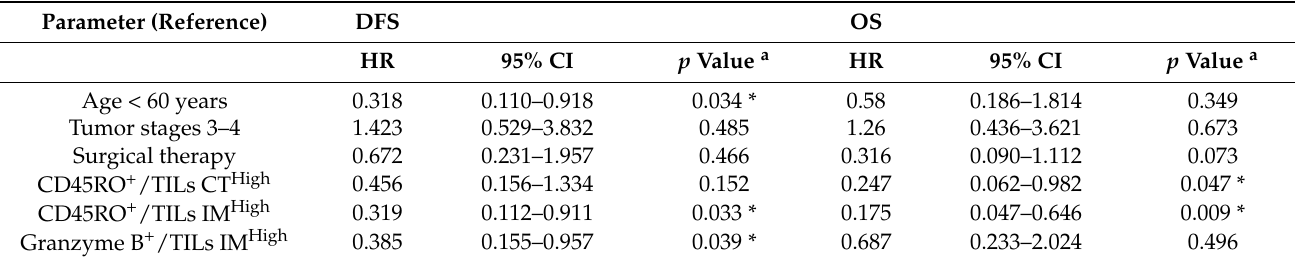
Table 2. Results of a multivariate Cox regression analysis for DFS and OS. Cox regression analyses, including an interaction term between CD45RO + and Granzyme B + expressions and patient char- acteristics, were performed. CD45RO + /TILs IM High and Granzyme B + /TILs IM High group hazard ratios showed a significant correlation for the DFS in multivariate. The CD45RO + /TILs High group’s hazard ratio in both CT and IM exhibited a significant correlation for the OS in multivariate. HR hazard ratio; CI confidence interval; DFS disease-free survival; OS overall survival; CT center of tumor; IM invasive margin.